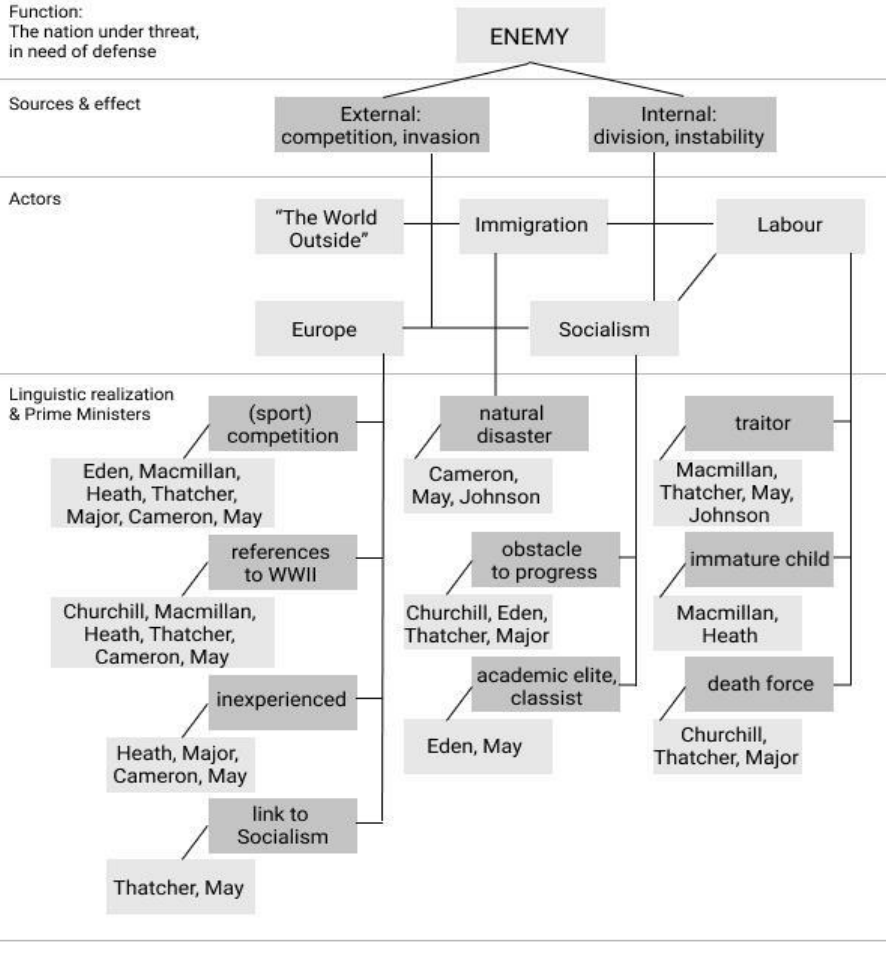
Figure 2. Discursive Strategy of Enemy Creation.